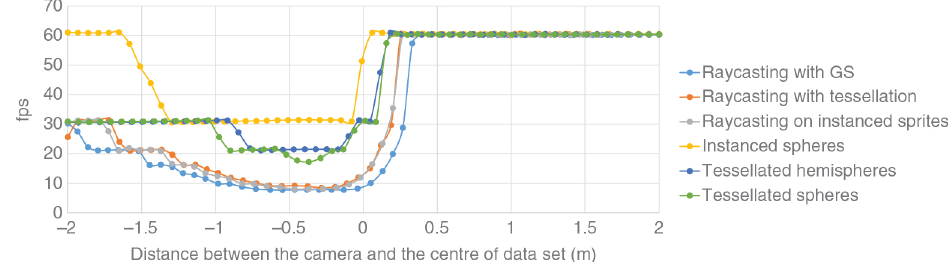
Figure 7: Frame rate over time while flying through 1RWE starting at 2 m distance and ending 2 m behind the data